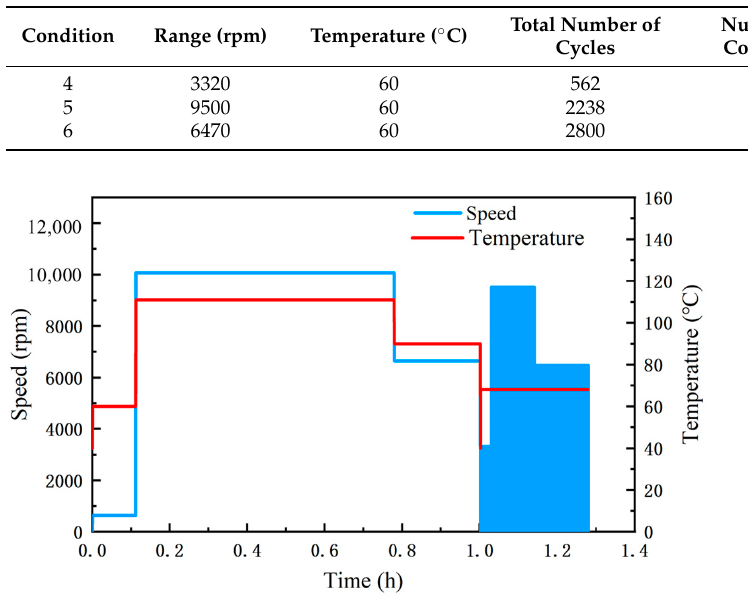
Figure 30. Load spectrum for accelerated tests.